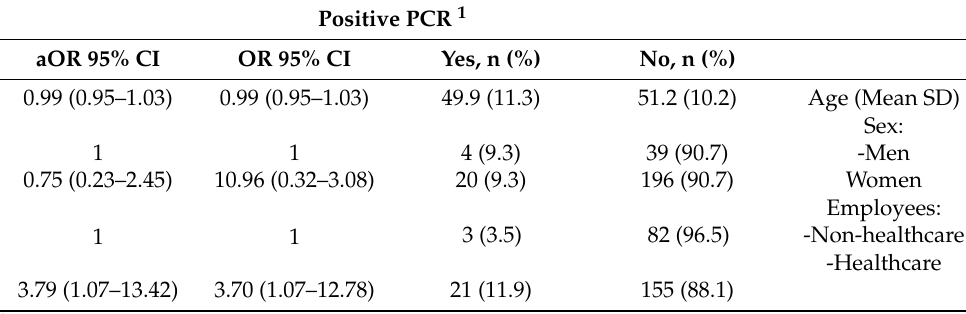
Table 4. Relationship between positive PCR and the professional profile.